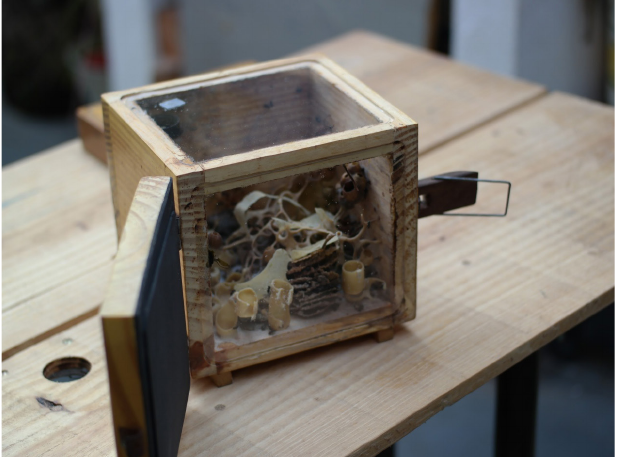
Fig 3 . Internal view (Photo by André